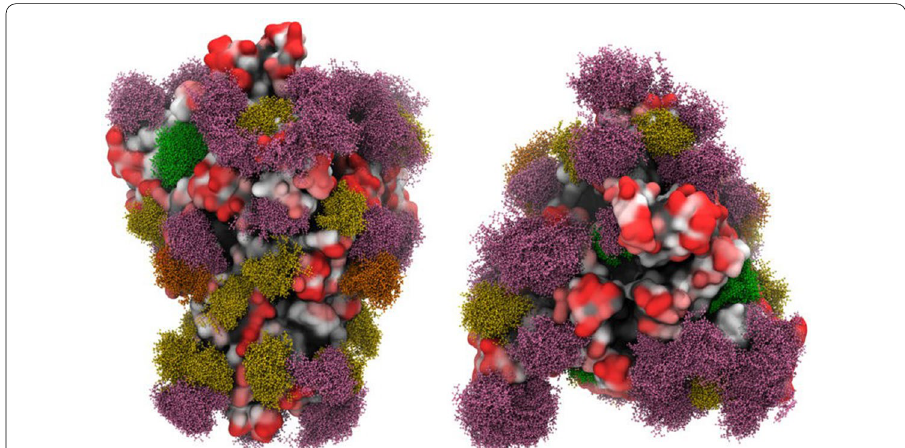
Fig. 3 Overlay of snapshots from molecular dynamics (MD) simulation of SARS‑CoV‑2 S glycoprotein with site‑specific glycosylation. The glycans are shown in ball‑and‑stick representation: high mannose (green), paucimannose (dark yellow), hybrid (orange), and biantennary complex (purple)